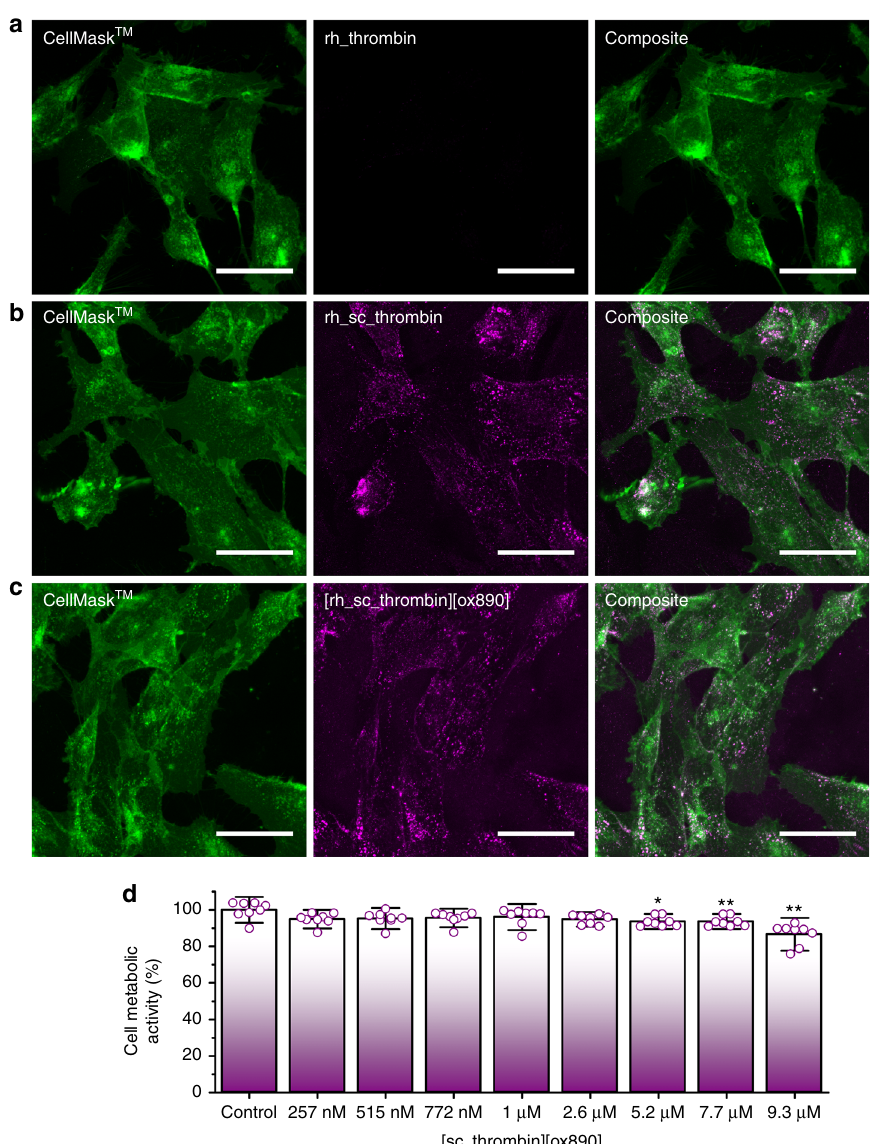
Fig. 3 Evaluation of rh_thrombin, rh_sc_thrombin and [rh_sc_thrombin][ox890] hMSC plasma membrane af fi nity. Cells labelled with CellMask ™ Deep Red (green) and corresponding rhodamine labelled thrombin (magenta). a Native (rh_thrombin) thrombin at T = 0 h. b Cationised (sc_rh_thrombin) thrombin at T = 0 h. c Polymer surfactant conjugate ([rh_sc_thrombin][ox890]) thrombin at T = 0 h. Scale bars represent 50 µ m. d MTS cell metabolic activity assay ( n = 8) of hMSCs after labelling with [sc_thrombin][ox890] compared to unlabelled controls. Data reported as means ± s.d. Dunnett ’ s test; * p